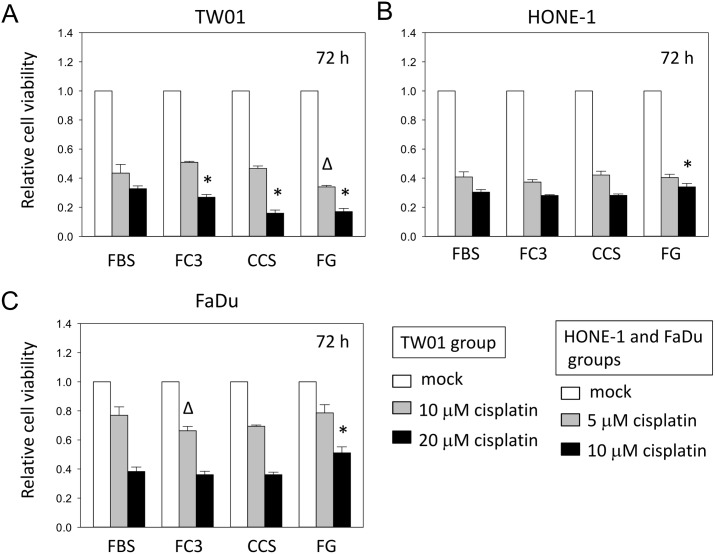
Cytotoxicity assays of cells cultured in alternative sera.Viability assays of cisplatin-treated cells cultured in different sera were performed using a standard MTT assay at 72 h. Cell viability is presented as a relative value when the mock-treated cells were adjusted to 1.0. (A) TW01 cells. Δ: p<0.05 compared with 10 μM cisplatin-treated cells in FBS. *: p<0.05 compared with 20 μM cisplatin-treated cells in FBS. (B) HONE-1 cells. *: p<0.05 compared with 10 μM cisplatin-treated cells in FBS. (C) FaDu cells. Δ: p<0.05 compared with 5 μM cisplatin-treated cells in FBS. *: p<0.05 compared with 10 μM cisplatin-treated cells in FBS. Data indicate the average value of triplicates (mean ± SD).